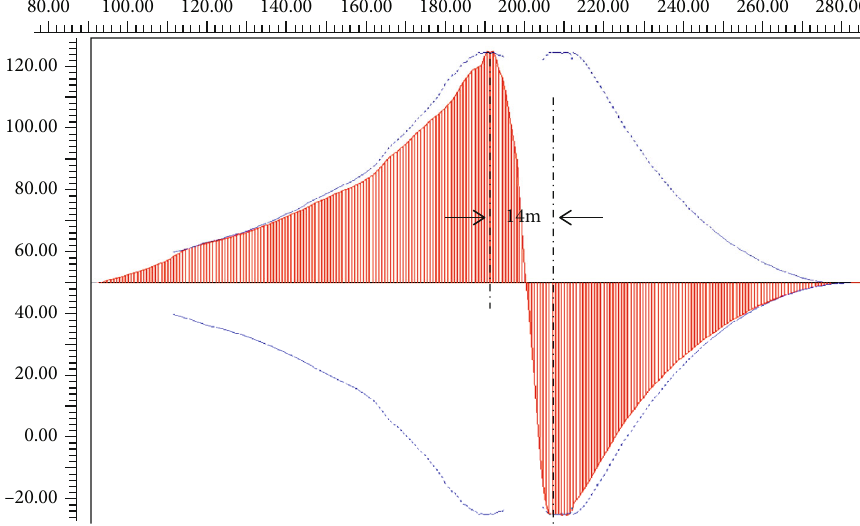
Figure 4: Bending moment diagram of lining after fault